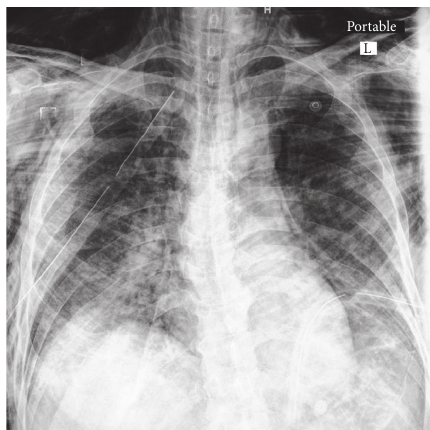
Figure 2: Chest X-ray showing pneumomediastinum and subcutaneous emphysema with inserted thoracostomy